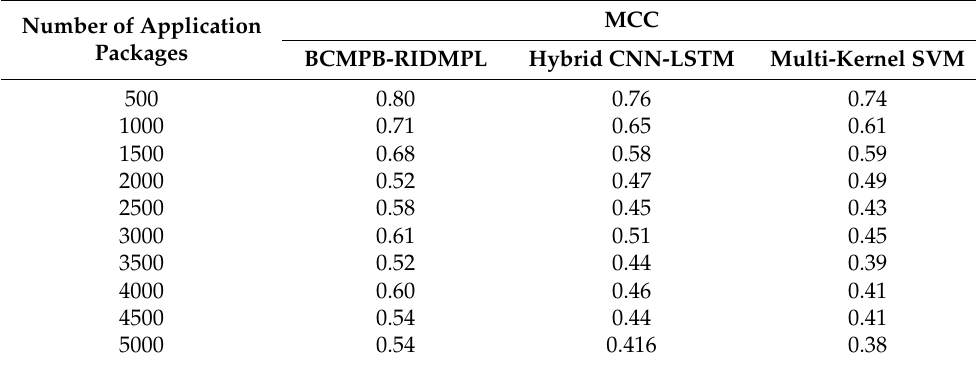
Table 3. Comparison of Matthews correlation coefficient.